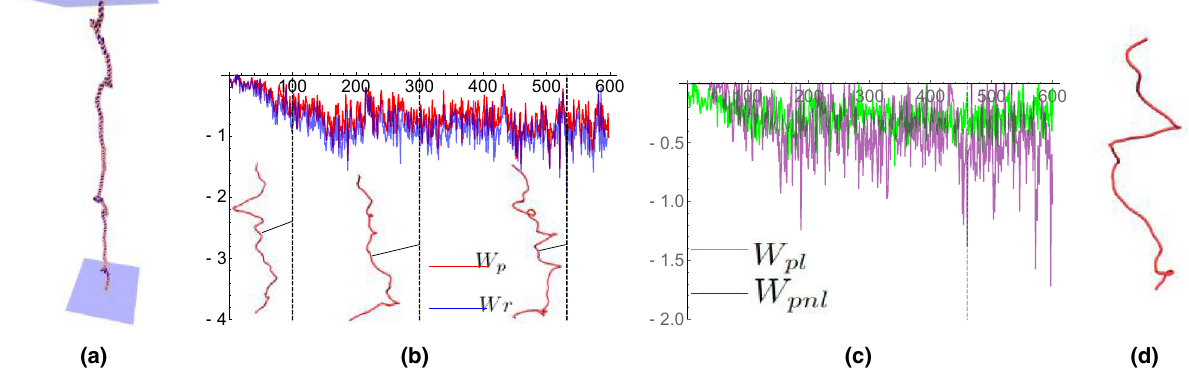
Figure 6. Results from simulations of an Lk = 40 DNA helix (undertwisted) placed under a 2pN extension force. Small kinked structures occasionally form along the length of the structure as shown in ( a ). Shown in ( b ) are writhe time series plots. The W p values are shown in red and the Wr values are shown in blue. The Wr values are consistently larger in magnitude but the variations in magnitude follow a very similar pattern. Example axis curves from the time series are shown; they correspond to the times marked by the dashed vertical lines. The curves’ width/height ratios are 0.3, chosen for clarity (0.1 would be the actual ratio). ( b ) A comparison of W pl and W pnl for the W p calculations shown in ( a ). There is a mixture of local W pl and non-local writhing values W pnl of roughly equal value. Some spikes in W pnl were found to arise from temporary loop formation. The dashed line indicates one such example whose curve is shown in ( d ). The spike in W pnl can be seen to correspond to the tight loop towards the bottom end of the curve.